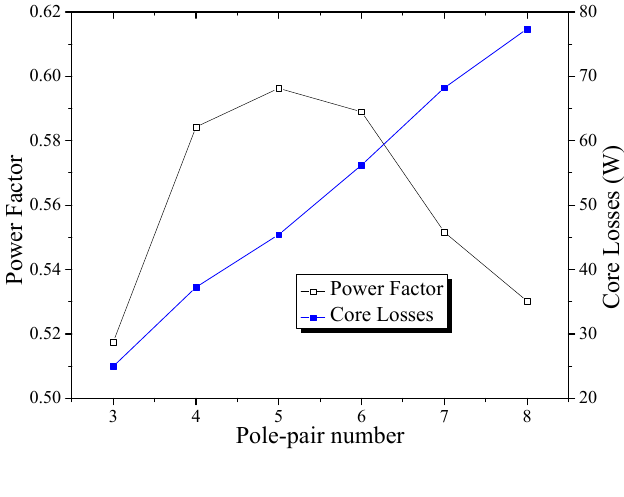
Figure 12. Variation of power factor and core losses versus pole-pair